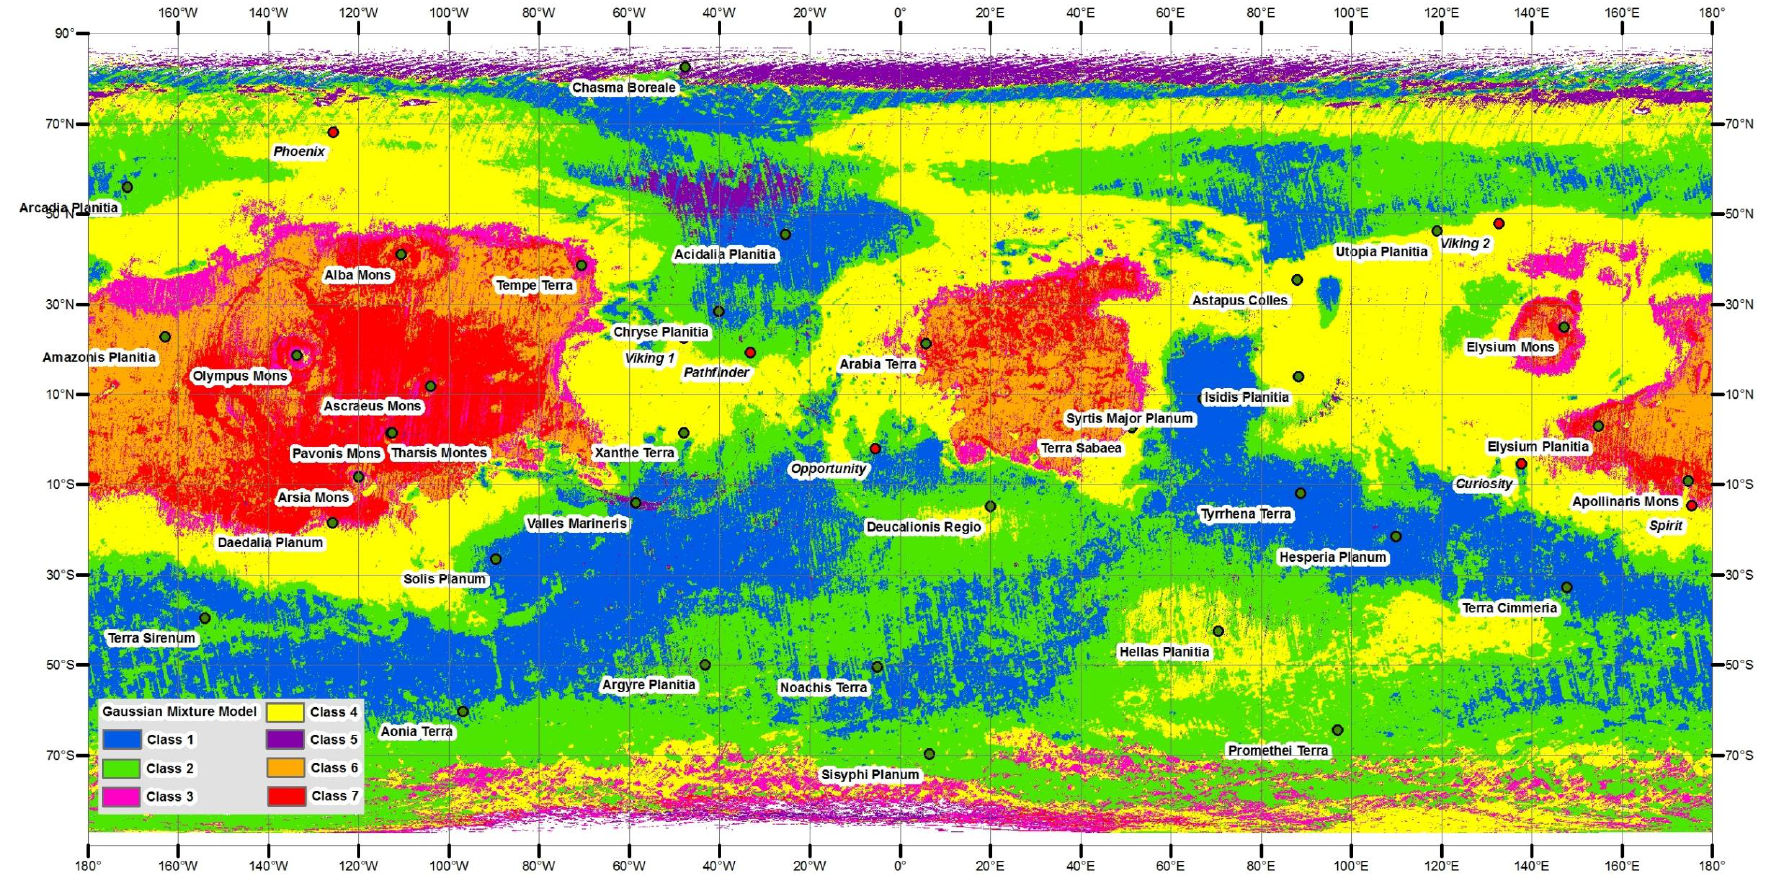
Figure 12. Spatial distribution of seven classes from the Expectation Maximisation of a Gaussian Mixture Model, classifying Martian thermal inertia and albedo. Each pixel is assigned to its most likely (highest probability)